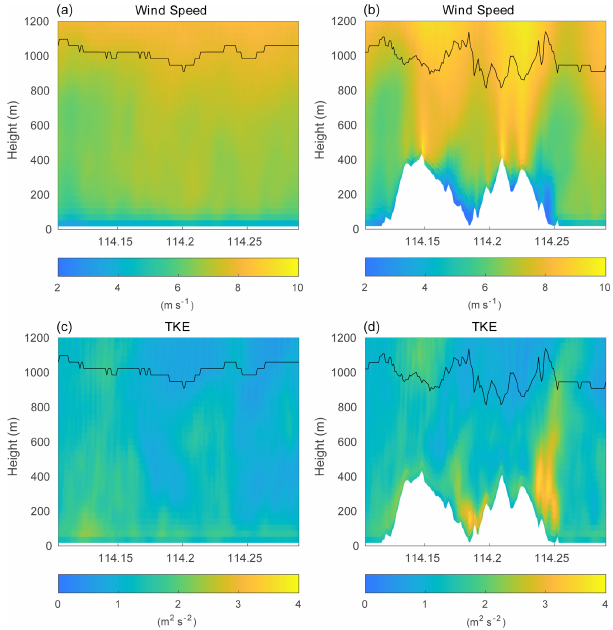
Figure 8. Vertical cross section of the horizontal wind speed (a, b) and total TKE (c, d) along latitude 22.275 ◦ N at hour 4 for simula- tions without terrain (left column; HOMF/HETF case) and with ter- rain (right column; TERW case). The black line indicates the PBL height.